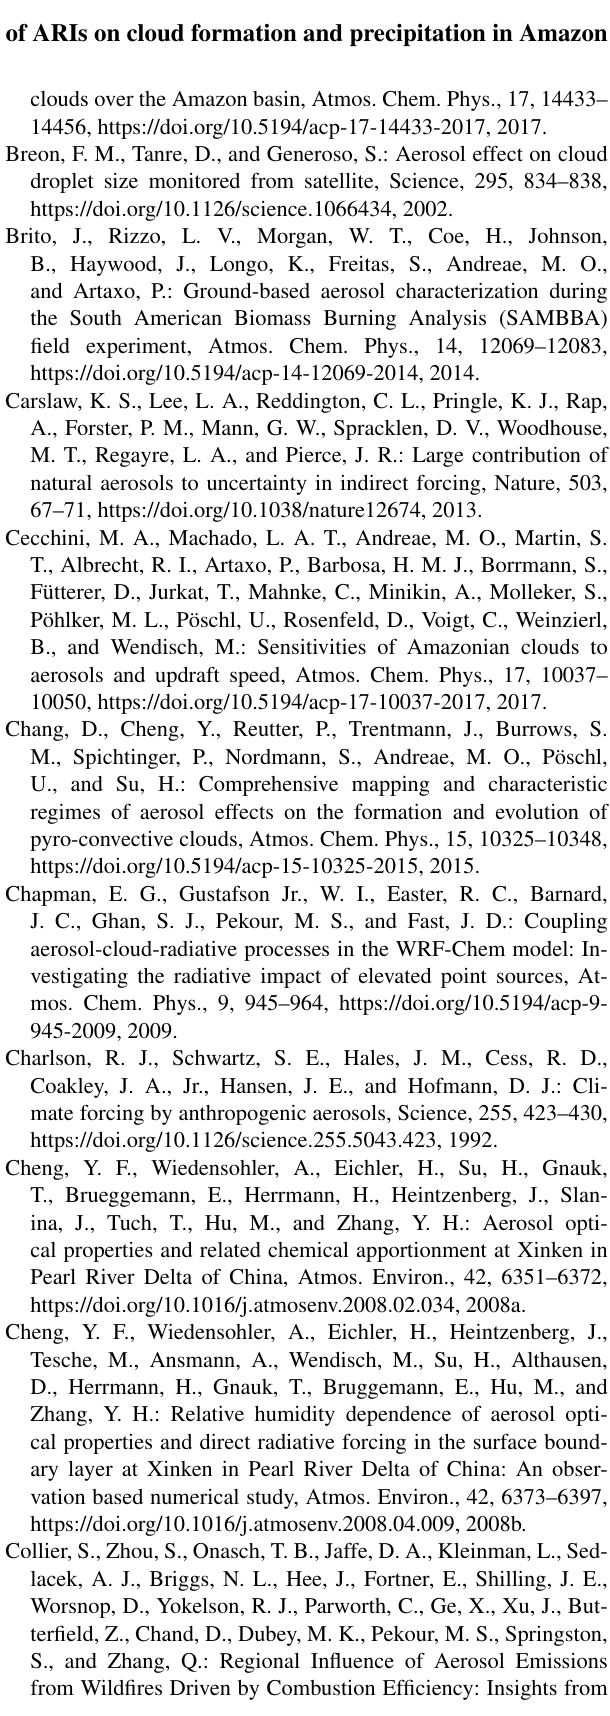
and Laskin, A.: Technical Note: Evaluation of the WRF-Chem ”Aerosol Chemical to Aerosol Optical Properties” Module using data from the MILAGRO campaign, Atmos. Chem. Phys.,